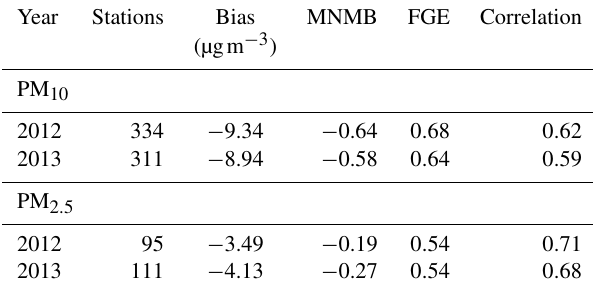
Table 5. Statistics of the comparison between the MOCAGE sim- ulation and the AQeR database measurements, corresponding to classes 1 to 5 from the classification of Joly and Peuch (2012) for the years 2012 and 2013. The table presents results for PM 10 and PM 2 . 5 . Year Stations Bias MNMB FGE Correlation (µgm − 3